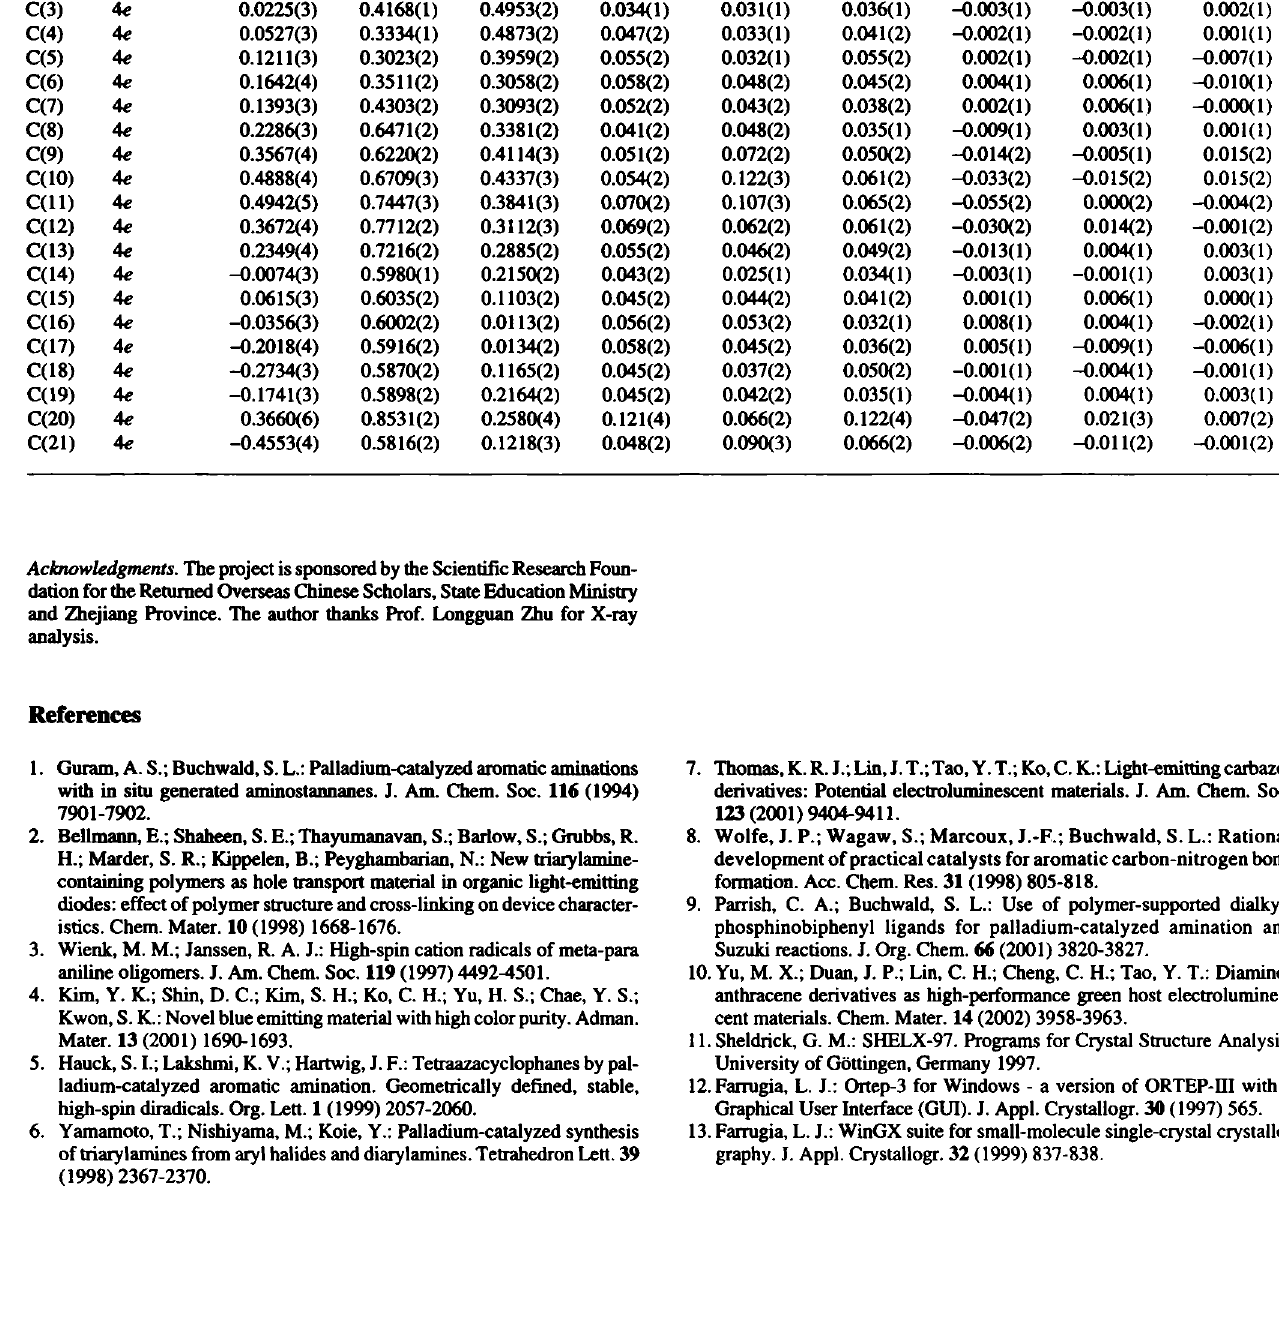
Table 3. Atomic coordinates and displacement parameters (in A 2